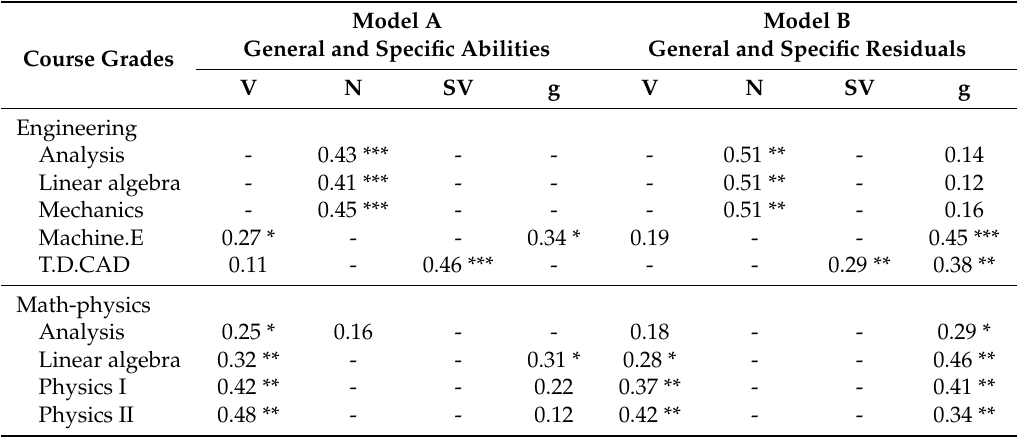
Figure 3. A SEM with three correlated factors for predicting grades among math-physics students ( N = 167). Bolded values indicate p < 0.001; ** p < 0.01; * p < 0.05. Table 9. Standardized path coefficients for models A and B in each